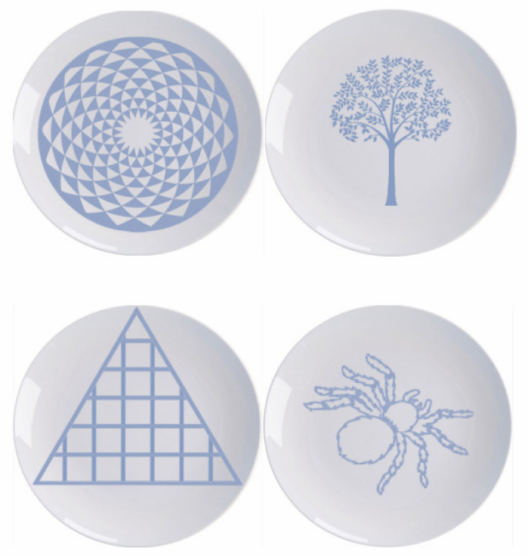
Figure 1. Example of patterned plates. The classical aesthetic patterned plates are on the left, and expressive ones on the right, with high beauty on the top and low beauty on the